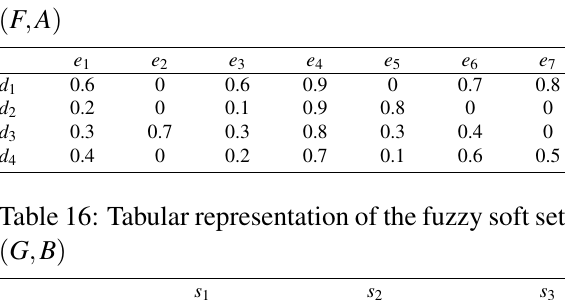
Table 15: Tabular representation of the fuzzy soft set